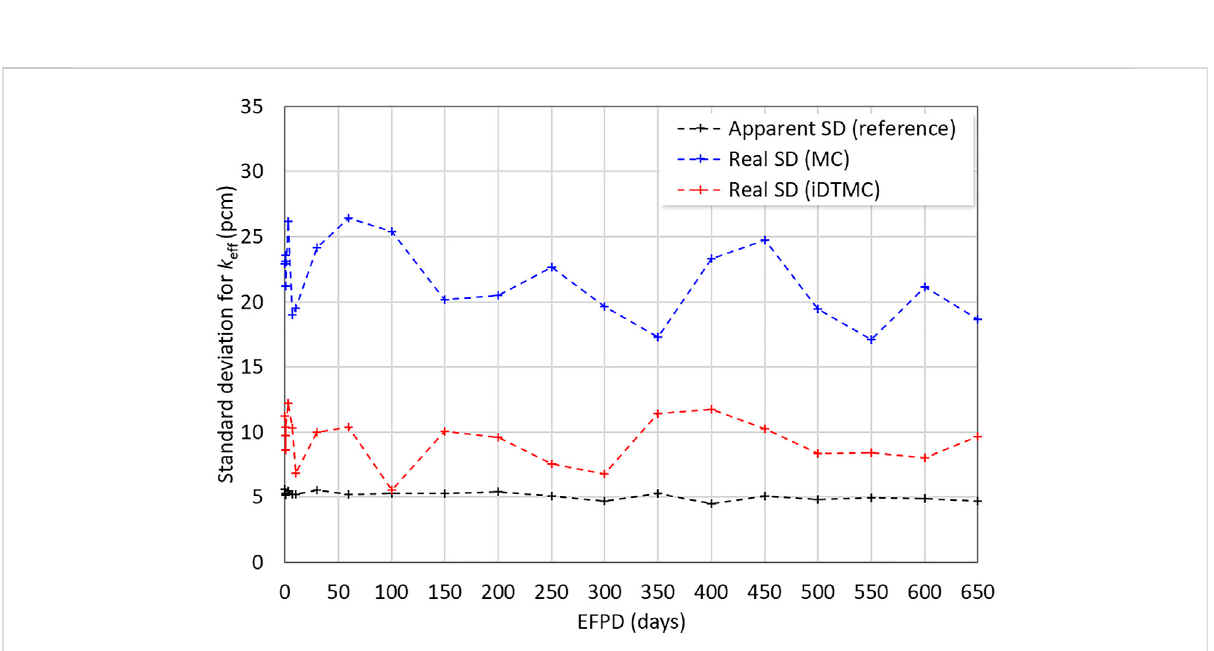
FIGURE 6 Standard deviations for burnup dependent criticality (active cycle